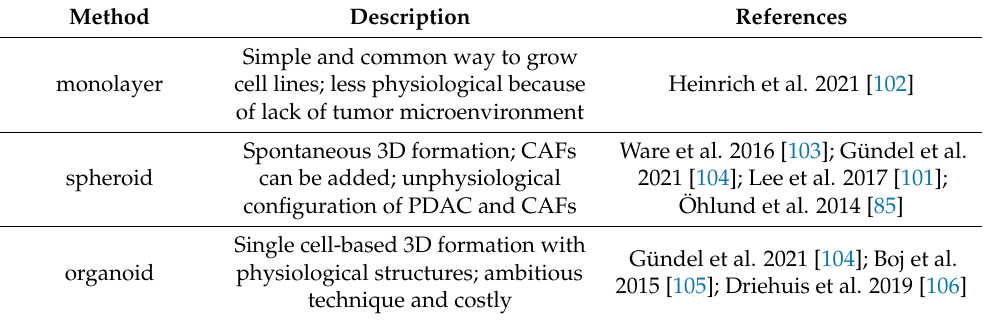
Table 3. Common 2D and 3D cell culture methods of pancreatic